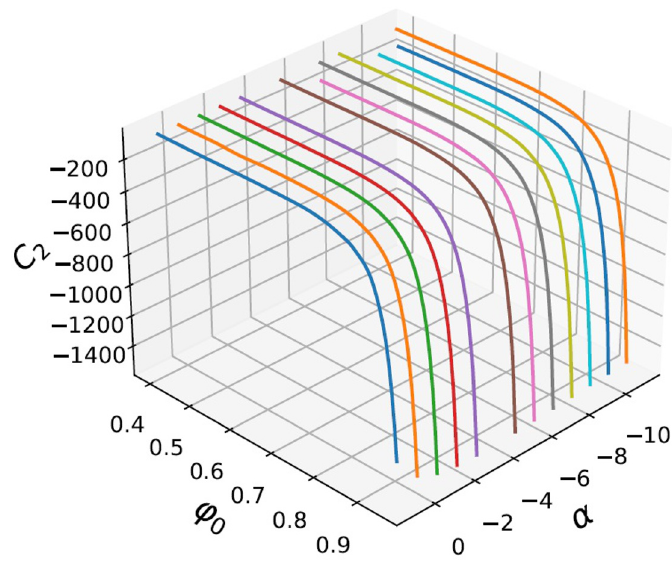
Figure 10 . The integration constant C 2 as a function of the two parameters, ϕ 0 and α , for Nut end-point solutions.